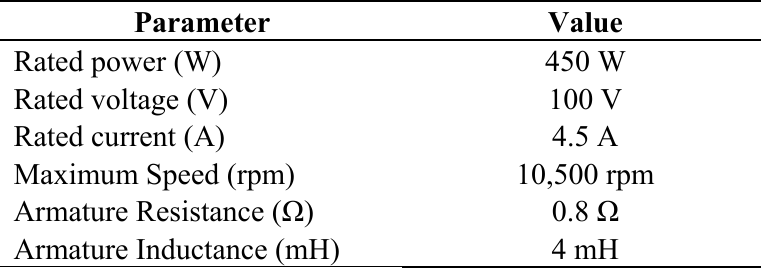
Table 2. Electric generator